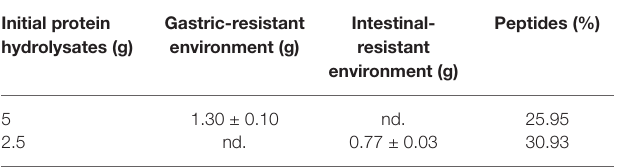
TABLE 5 | The gastrointestinal environment-resistant earthworm peptides. Initial protein hydrolysates (g)